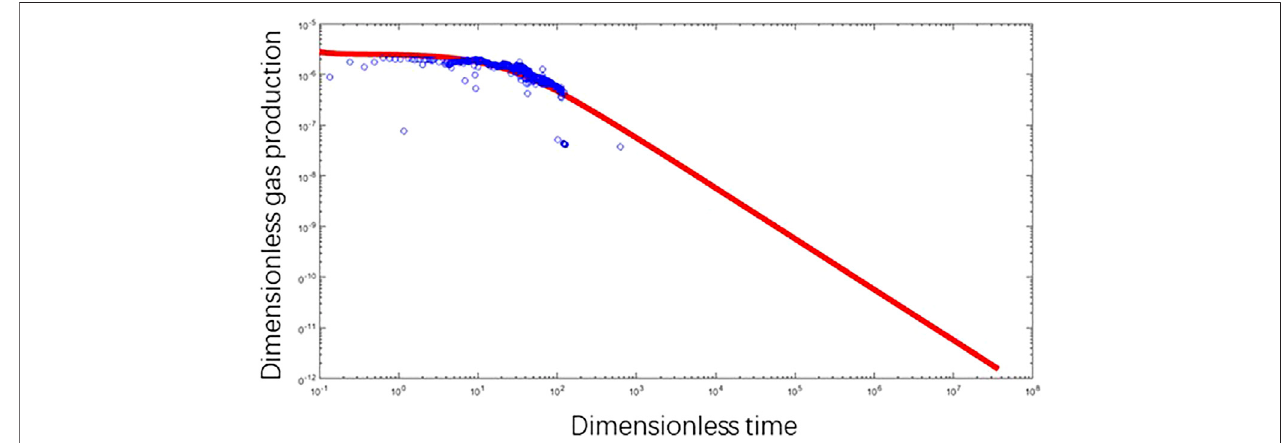
FIGURE 7 | The fi tting interpretation curve of production decline of Well M2.